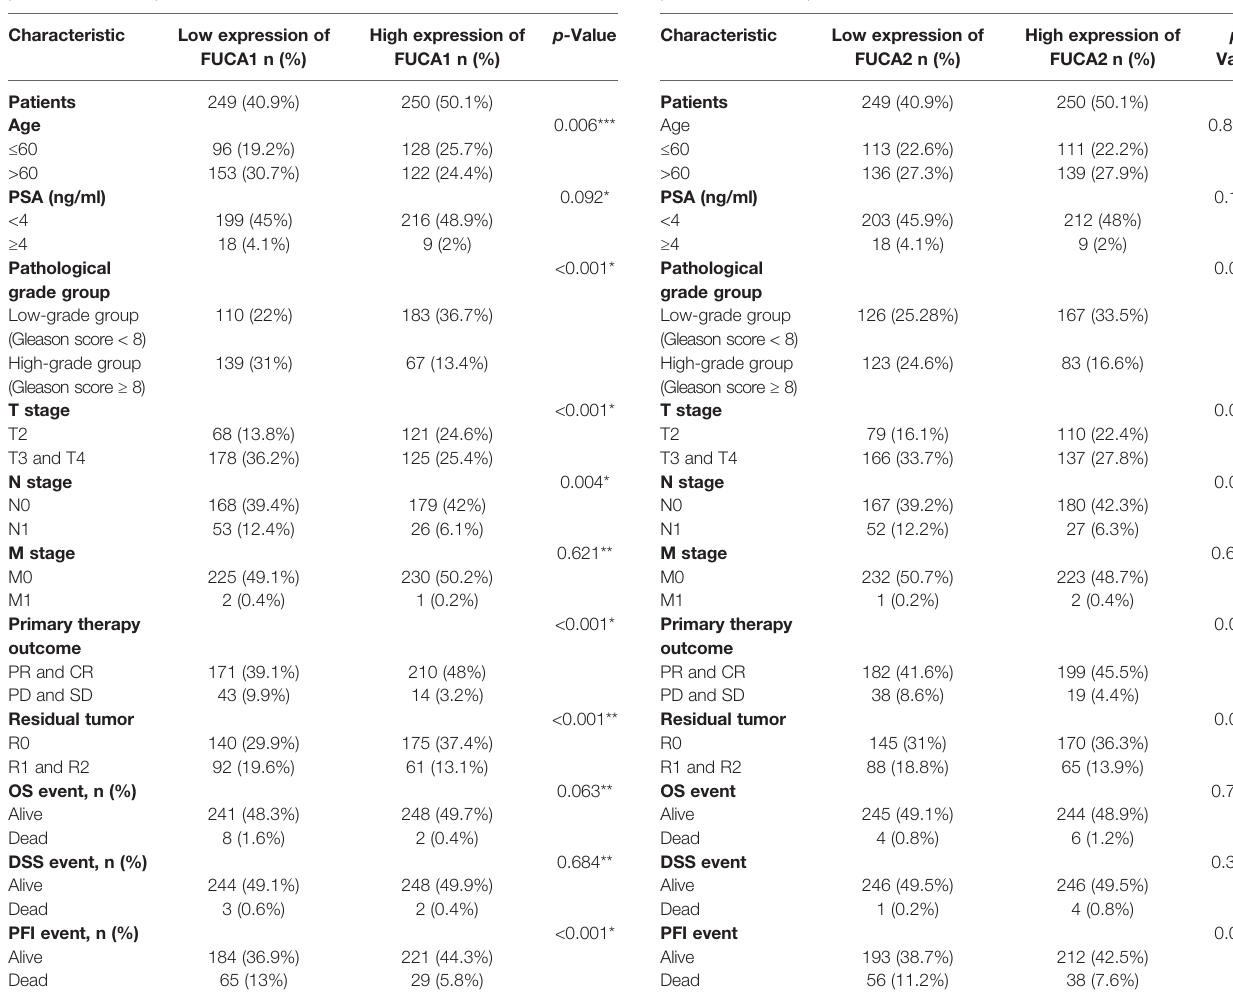
TABLE 4 | Correlations between FUCA2 expression and clinicopathological parameters of PCa